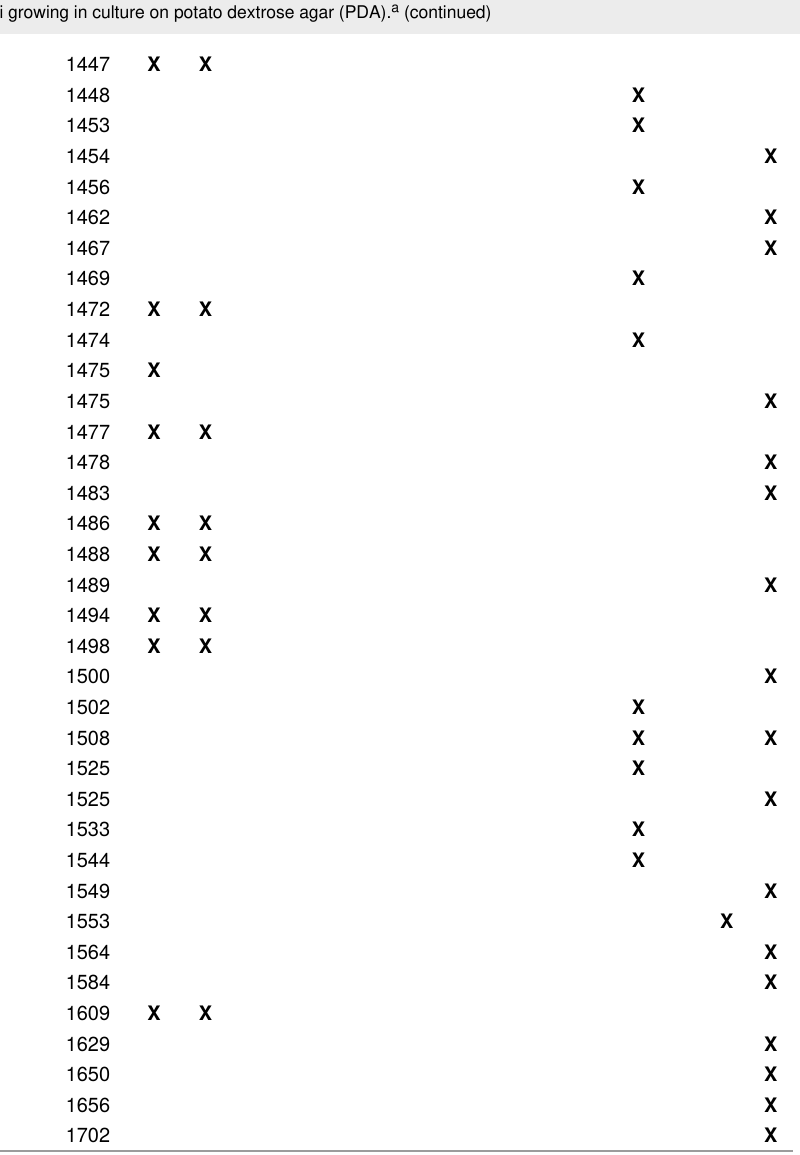
Both protein extracts containing the respective enzymes accepted the substrate GPP and produced monoterpenes (Figure 2). CxTPS1 produced myrcene ( 9 ) and ( E )- β -ocimene ( 10 ) in similar amounts. CxTPS2 produced ( E )- β -ocimene ( 10 ) as the major product and minor amounts of myrcene ( 9 ), ( Z )- β - ocimene ( 11 ), and linalool ( 5 ) (Figure 2). Only one sesquiter- pene product was formed by each TPS: CxTPS1 produced ( E , E )- α -farnesene ( 12 ) and CxTPS2 produced ( E )- β -caryophyl- lene ( 1 ). With GGPP, no enzyme activity was recorded